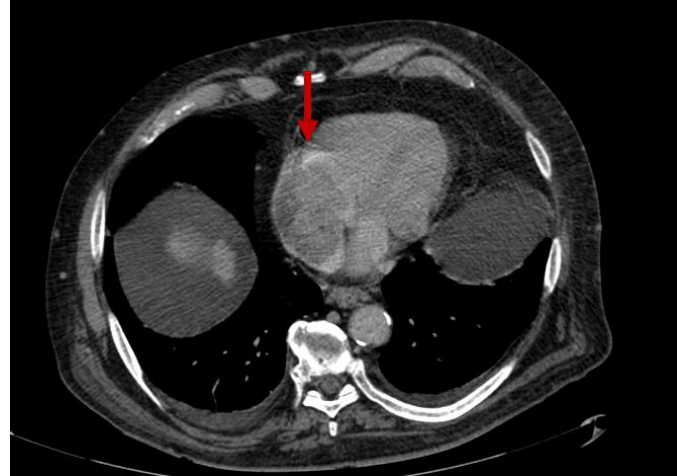
Figure 6. ICT in BD. The red arrow shows right-ventricle thrombosis.